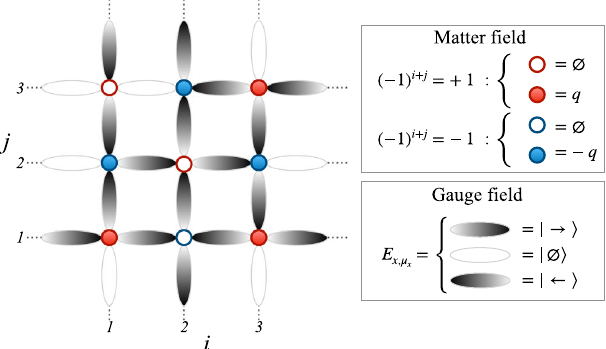
FIG. 1. Sketch of the 2D lattice gauge theory in the spin-1 representation. The cartoon of the square lattice shows a specific gauge-invariant configuration of the matter and gauge fields with zero total charge (three particles and three antiparticles). Stag- gered fermions represent matter and antimatter fields on a lattice bipartition: On the even (odd) bipartition, a full red (blue) site represents a particle (antiparticle). The gauge-field points in the positive direction of the color